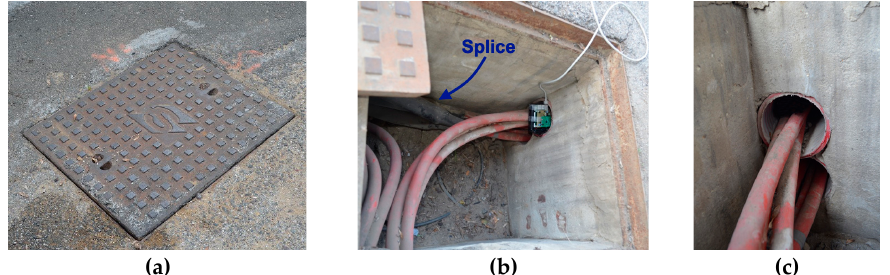
Figure 1. (a) Manhole cover; (b) manhole for a line direction change; and (c) cable layout in the Figure 1. ( a ) Manhole cover; ( b ) manhole for a line direction change; and ( c ) cable layout in the underground duct (view from the manhole). underground duct (view from the manhole).